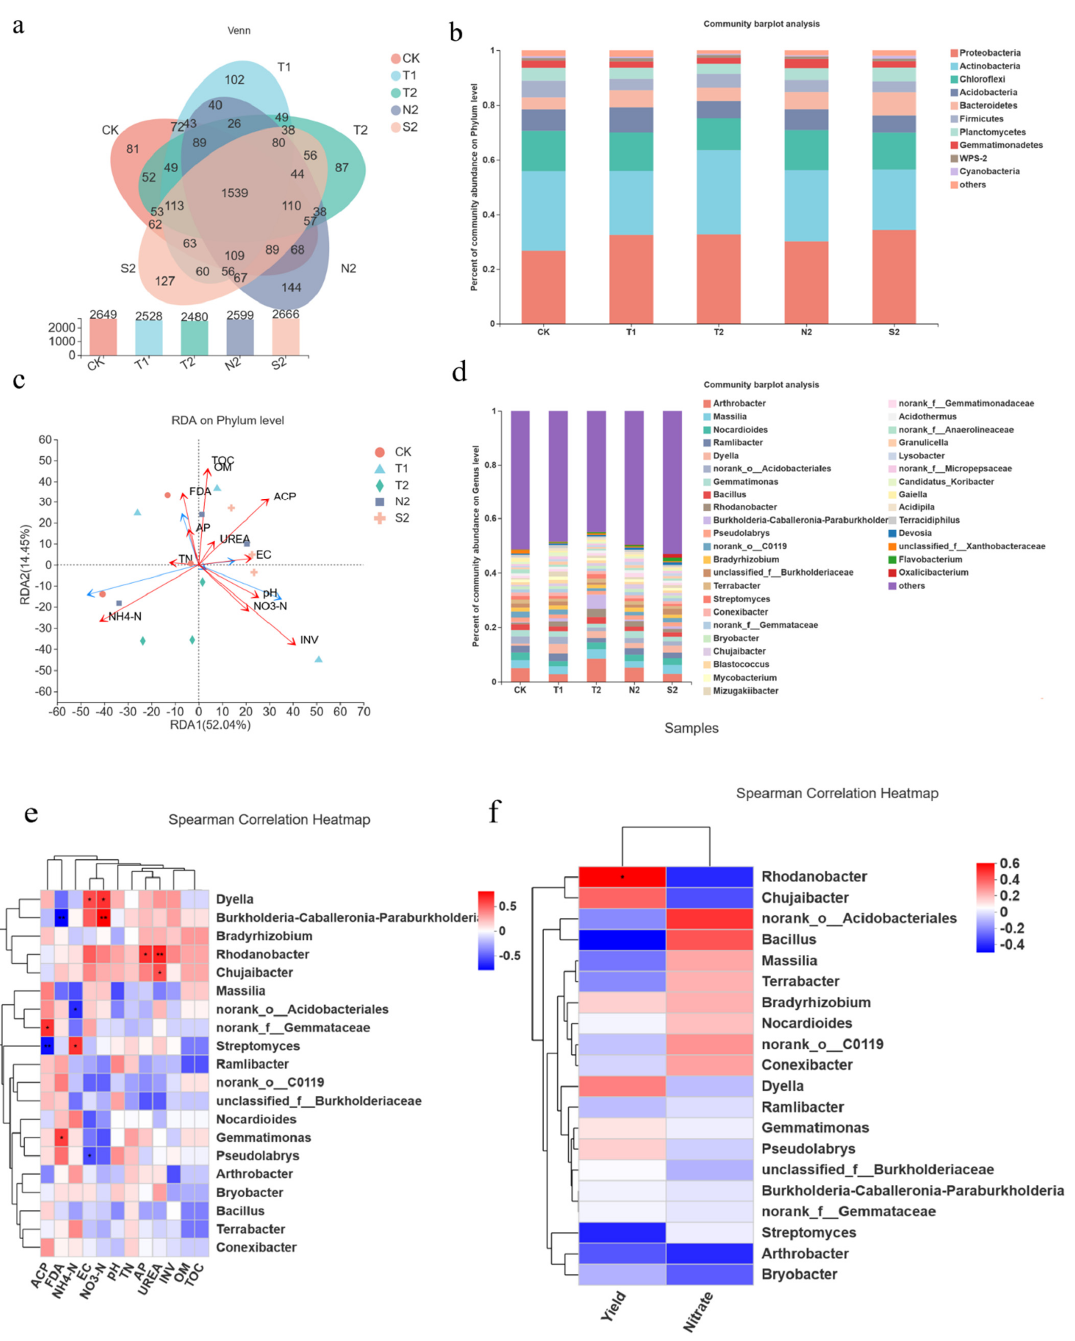
Figure 2. Number of common and unique OTUs based on bacteria ( a ) Venn analysis; relative abun- dances of bacteria ( b ) at the phylum level; redundancy analysis of the five (blue line) dominant bacteria ( c ) associated with soil properties; relative abundances of bacteria ( d ) at the genus level; the heatmap of the correlation between the top 20 dominant bacterial ( e ) genera associated with soil properties; the heatmap of the correlation between the top 20 dominant bacterial ( f ) genera associated with yield and nitrate content. Note: * at the 0.05 level (double-tailed), the correlation between them was significant; ** at 0.01 level (double-tailed), the correlation between them was